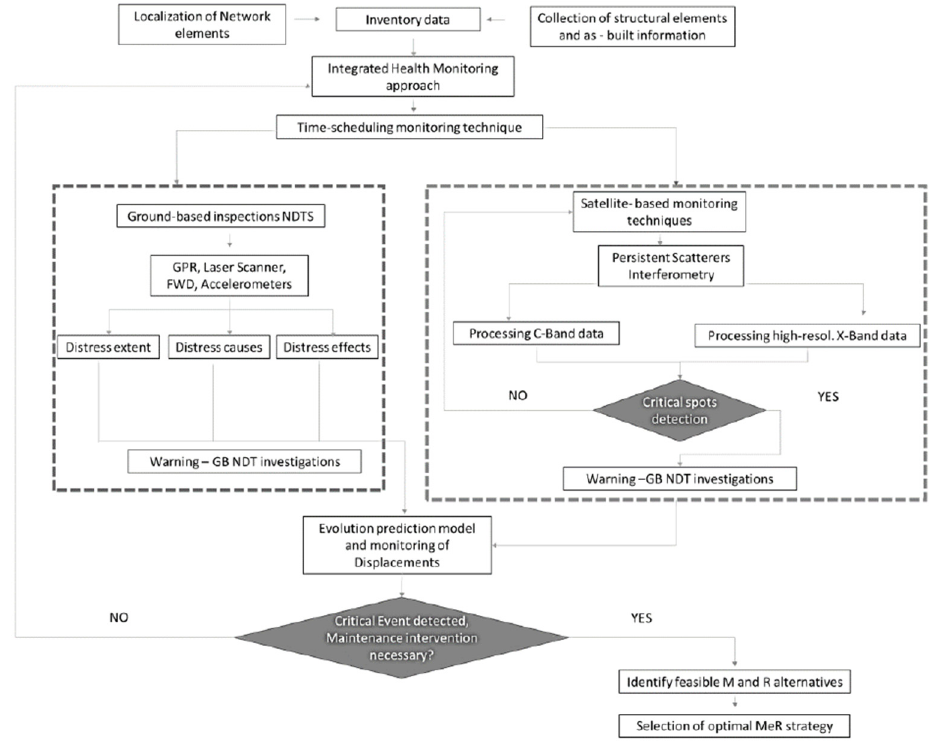
Figure 14. Flowchart of the proposed integrated health monitoring model for transport infrastructure management.